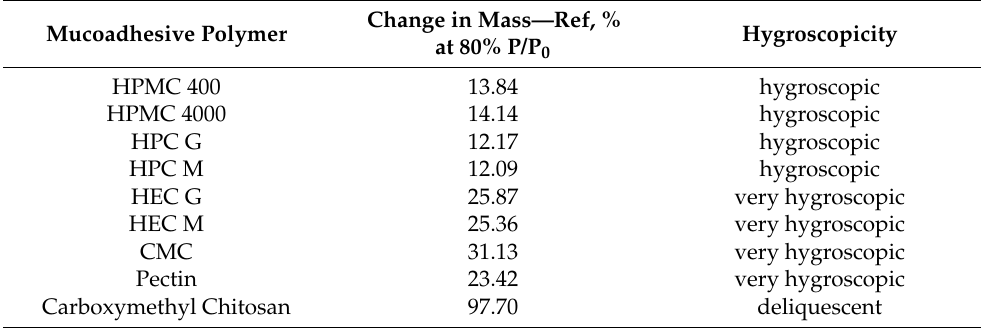
Table 4. Dynamic vapor sorption: change in the mass of the polymers at 80% relative humidity in the first cycle ( n =